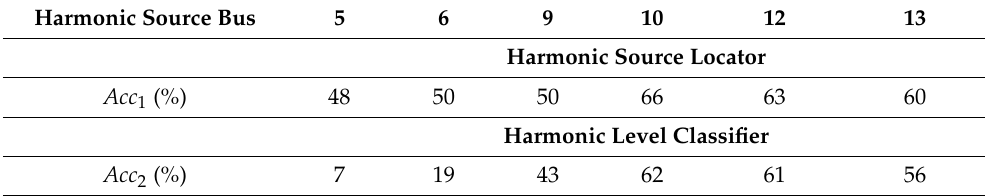
Table 3. Harmonic source locators and level classifier accuracies for Bayesian Learning.